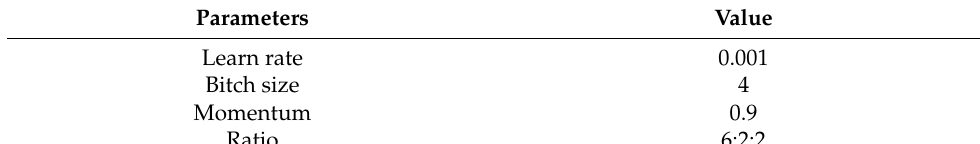
Table 5. Experimental parameters for each data set.